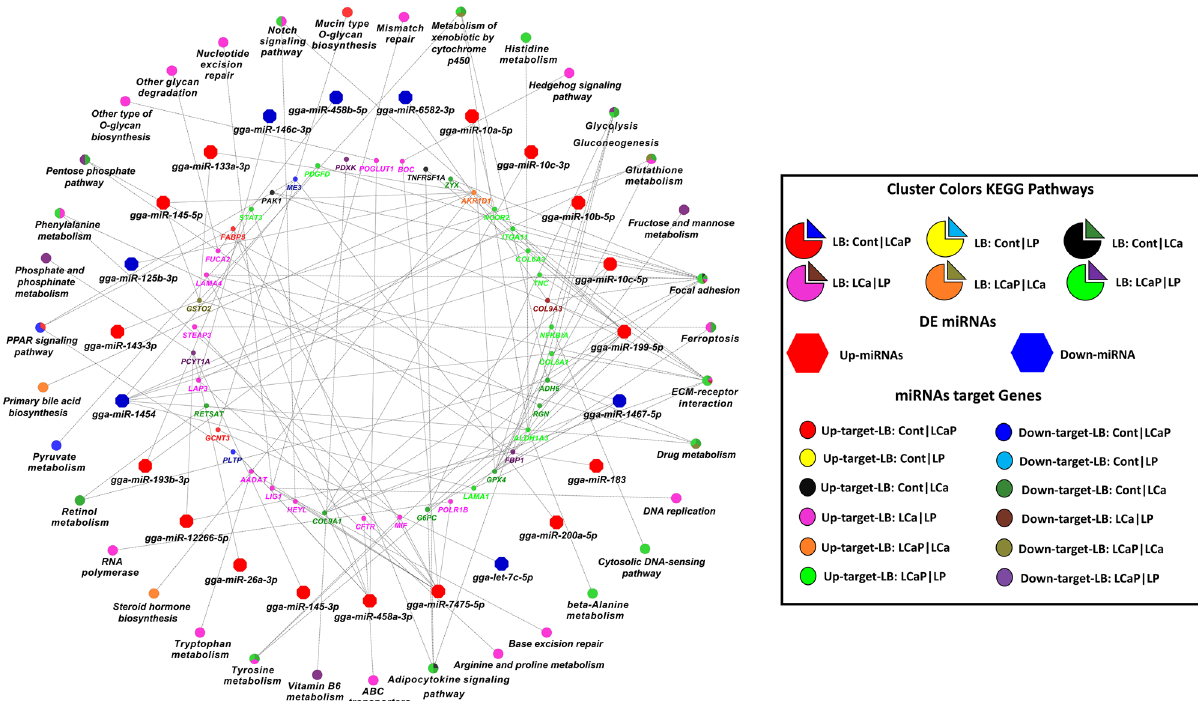
Figure 8. KEGG pathways enrichment analysis of differentially expressed (DE) known miRNAs and their DE target genes from pairwise comparisons between diet groups within LB strain. ClueGO (version 2.5.1) and Cluepedia (version 1.5.7) plugin in Cytoscape (version.3.6.1) environment performed KEGG pathways enrichment analysis. ClueGO generated functionally clustered KEGG annotation network of DE miRNAs and their DE target genes. P value was calculated by right-sided hypergeometric tests and Benjamin–Hochberg adjustment was used for multiple test correction. KEGG pathways with a P < 0.05 were considered